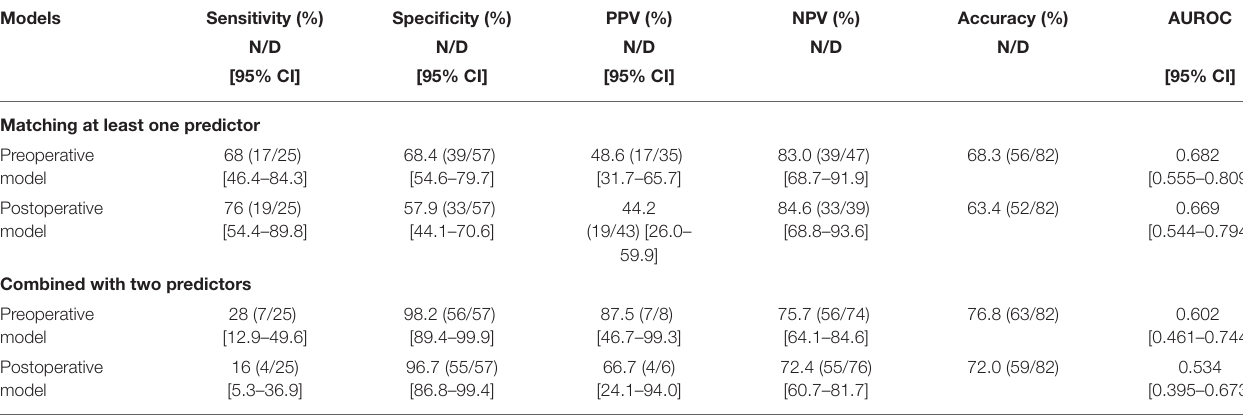
TABLE 4 | Prognostic performance of preoperative and postoperative prediction models.